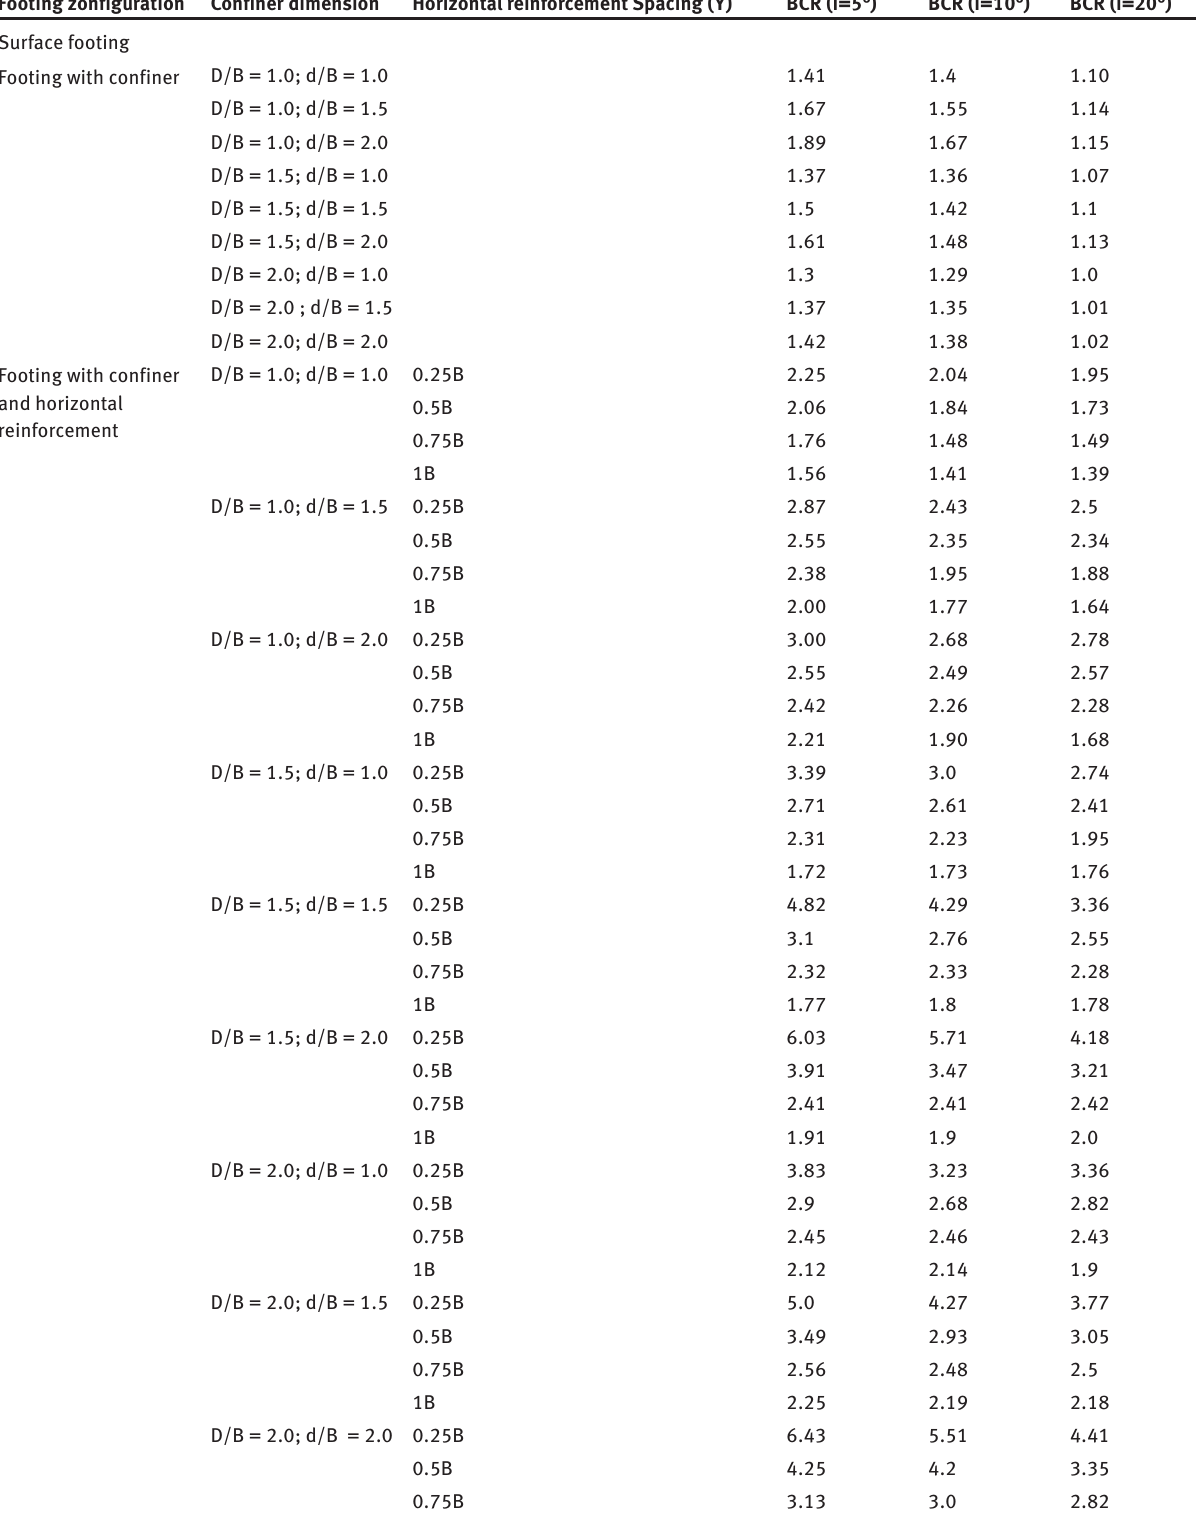
Table 4: Comparison of BCRs for different footing configurations under centric inclined loading. Footing zonfiguration Confiner dimension Surface footing Footing with confiner